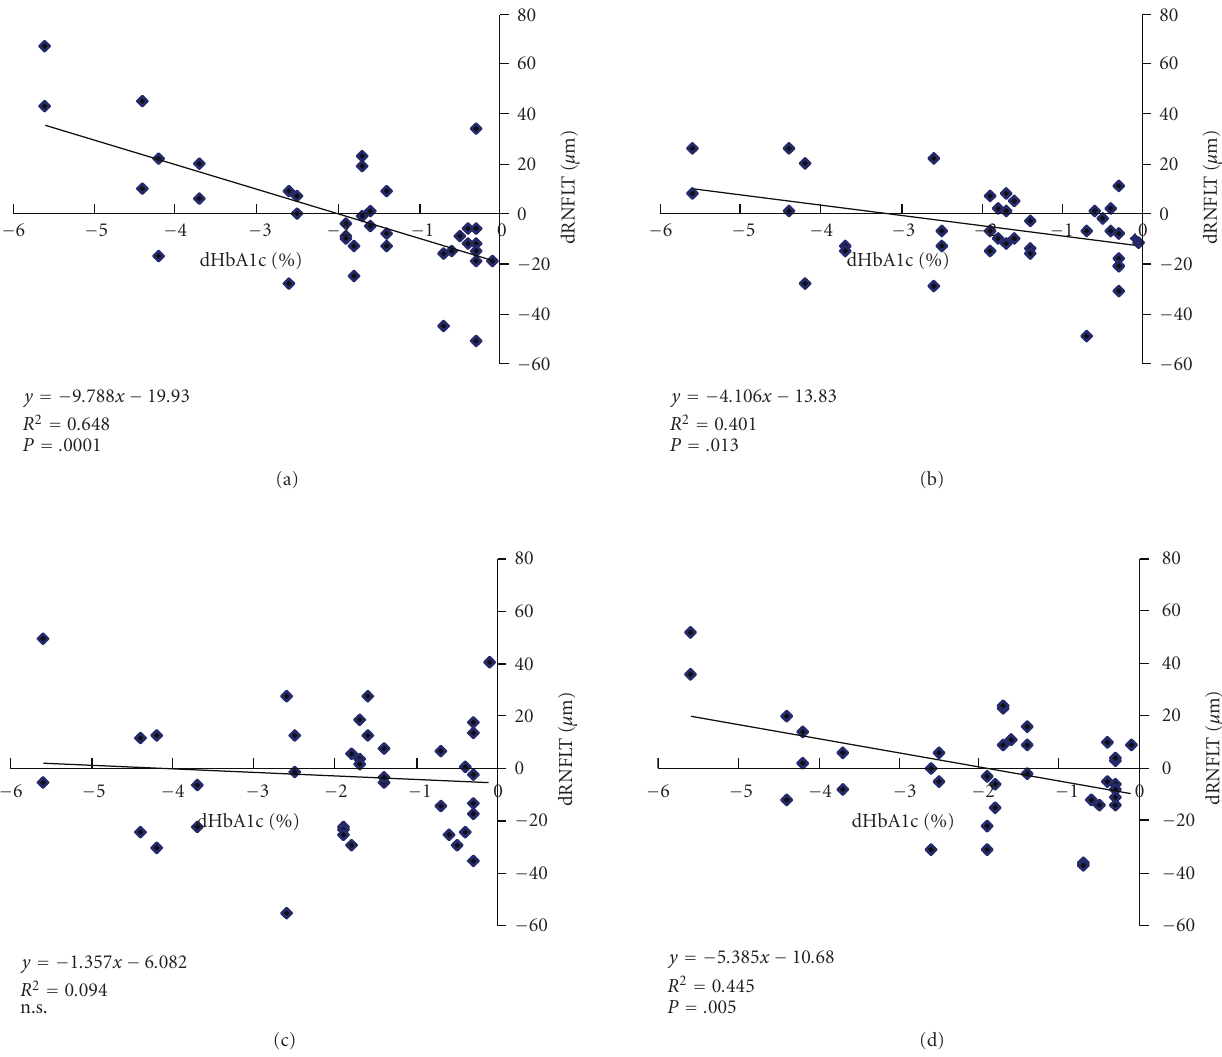
Figure 2: The relationship between HbA1c changes (dHbA1c) and RNFL thickness changes (dRNFLT) in (a) Temporal, (b) Superior, (c) Nasal, (d) Inferior quadrant area. The lines are from a linear regression analysis. There is a significant correlation in temporal ( P = . 0001), superior ( P = . 013) and inferior quadrant area ( P = . 005). There is no significant correlation in nasal quadrant